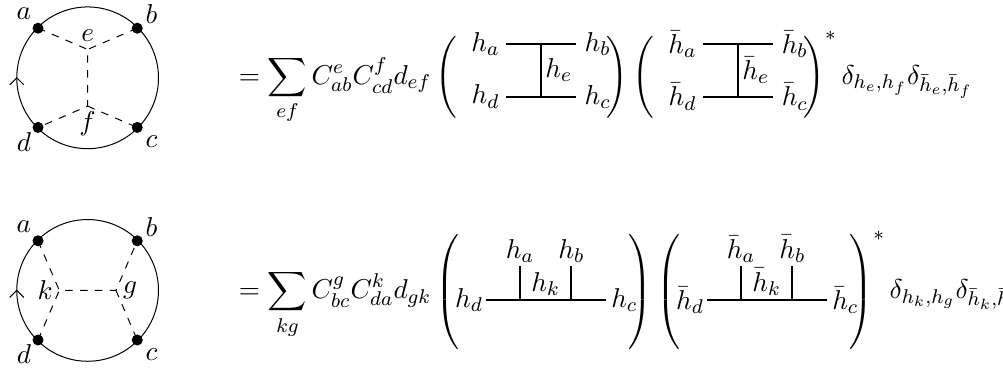
Figure 4 . Two ways of calculating a four-point defect (cid:12)eld correlation